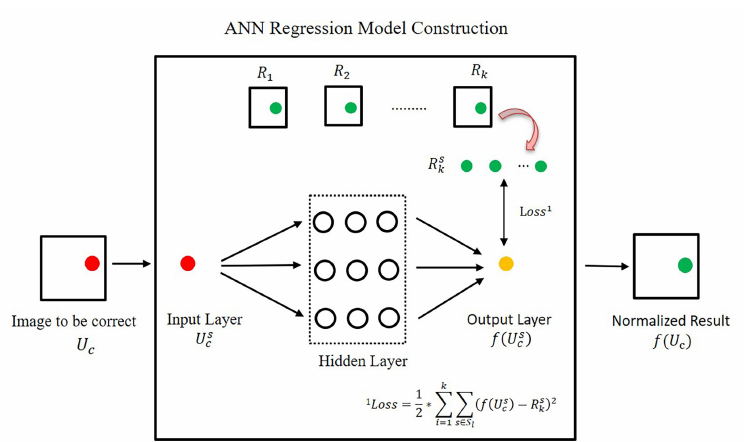
Figure 2. The schematic diagram of the artificial neural network (ANN) regression model used in